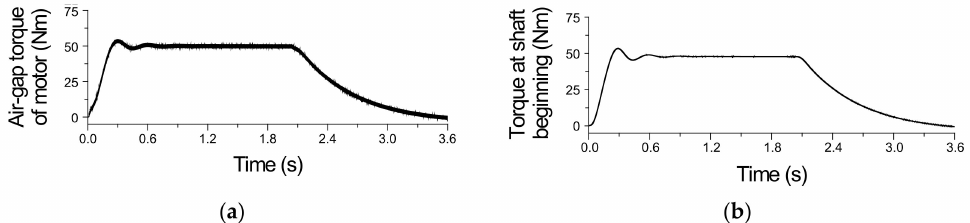
Figure 17. Waveforms of the air-gap torque ( a ) and the torque at the beginning of the shaft ( b ) during motor start-up in the system shown in Figure 7 for the 1 kg · m 2 moment of inertia of the total mass containing the rotor of the DC generator and the disc installed at the end of the shaft.